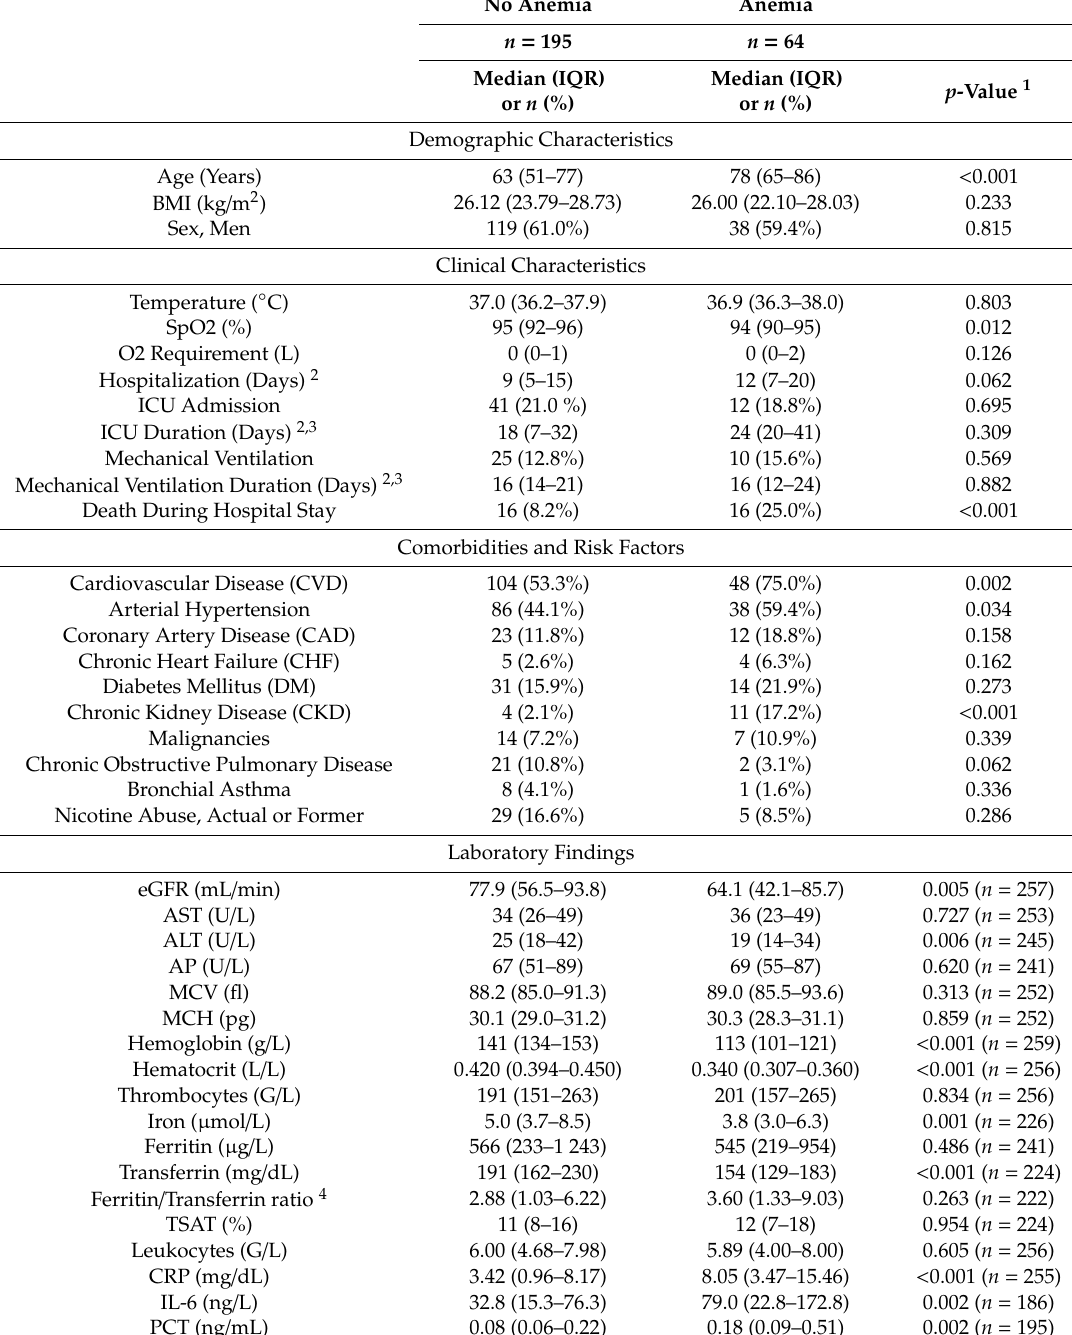
Table 1. Patients’ characteristics of anemic patients at hospital admission.